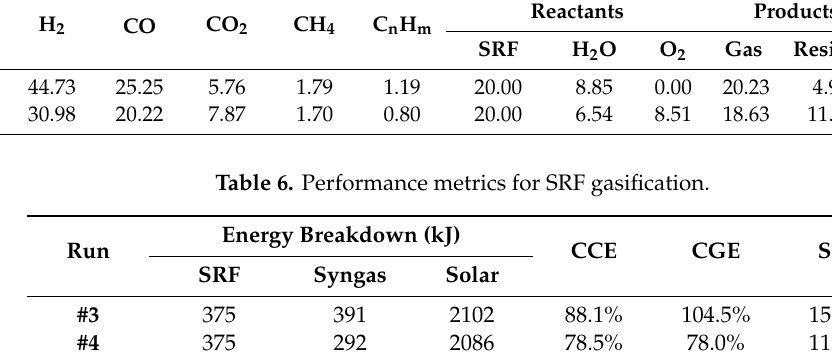
Table 5. Gas yield and mass balance closure for SRF gasification.